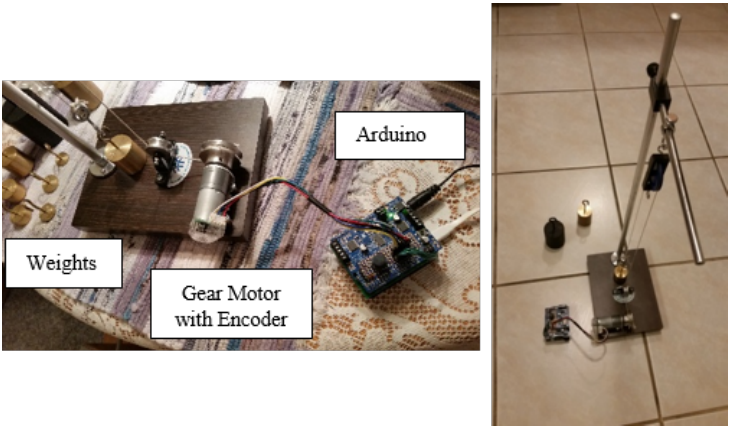
Figure 2. PID++ development and test